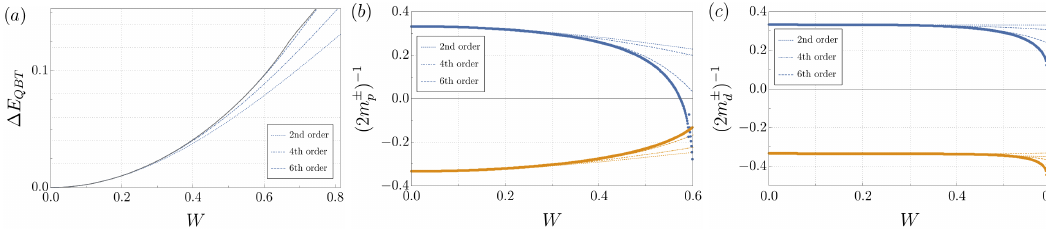
Figure 4: Renormalization of the quadratic band touching : Comparison of the = 144 and perturbation theory (dashed lines) and numerical calculations for L = F 12 / 2 π = F / L = 55 / 144 system across the magic-angle transition. (a) The shift of Q L 10 the QBT energy as W increases. Note that the QBT energy is not fixed due to lack of particle-hole symmetry. The QBT splits in the numerical calculation near W (cid:39) 0.65, and the energy difference is in the order of 10 − 3 , which is not visible in this scale. (b,c) The effective curvature of the upper (blue) QBT band and lower (yellow) QBT band in the direction of (b) principal axis and (c) the diagonal direction. As shown ≈ 0.573 identifies the magic-angle in (b), the diverging effective mass m + around W c p condition where part of the QBT has become